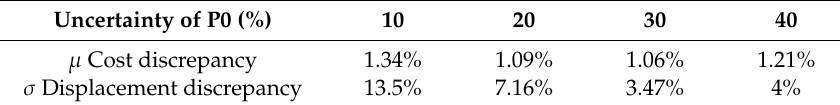
Table 7. Validation of the kriging surfaces varying the prestressing